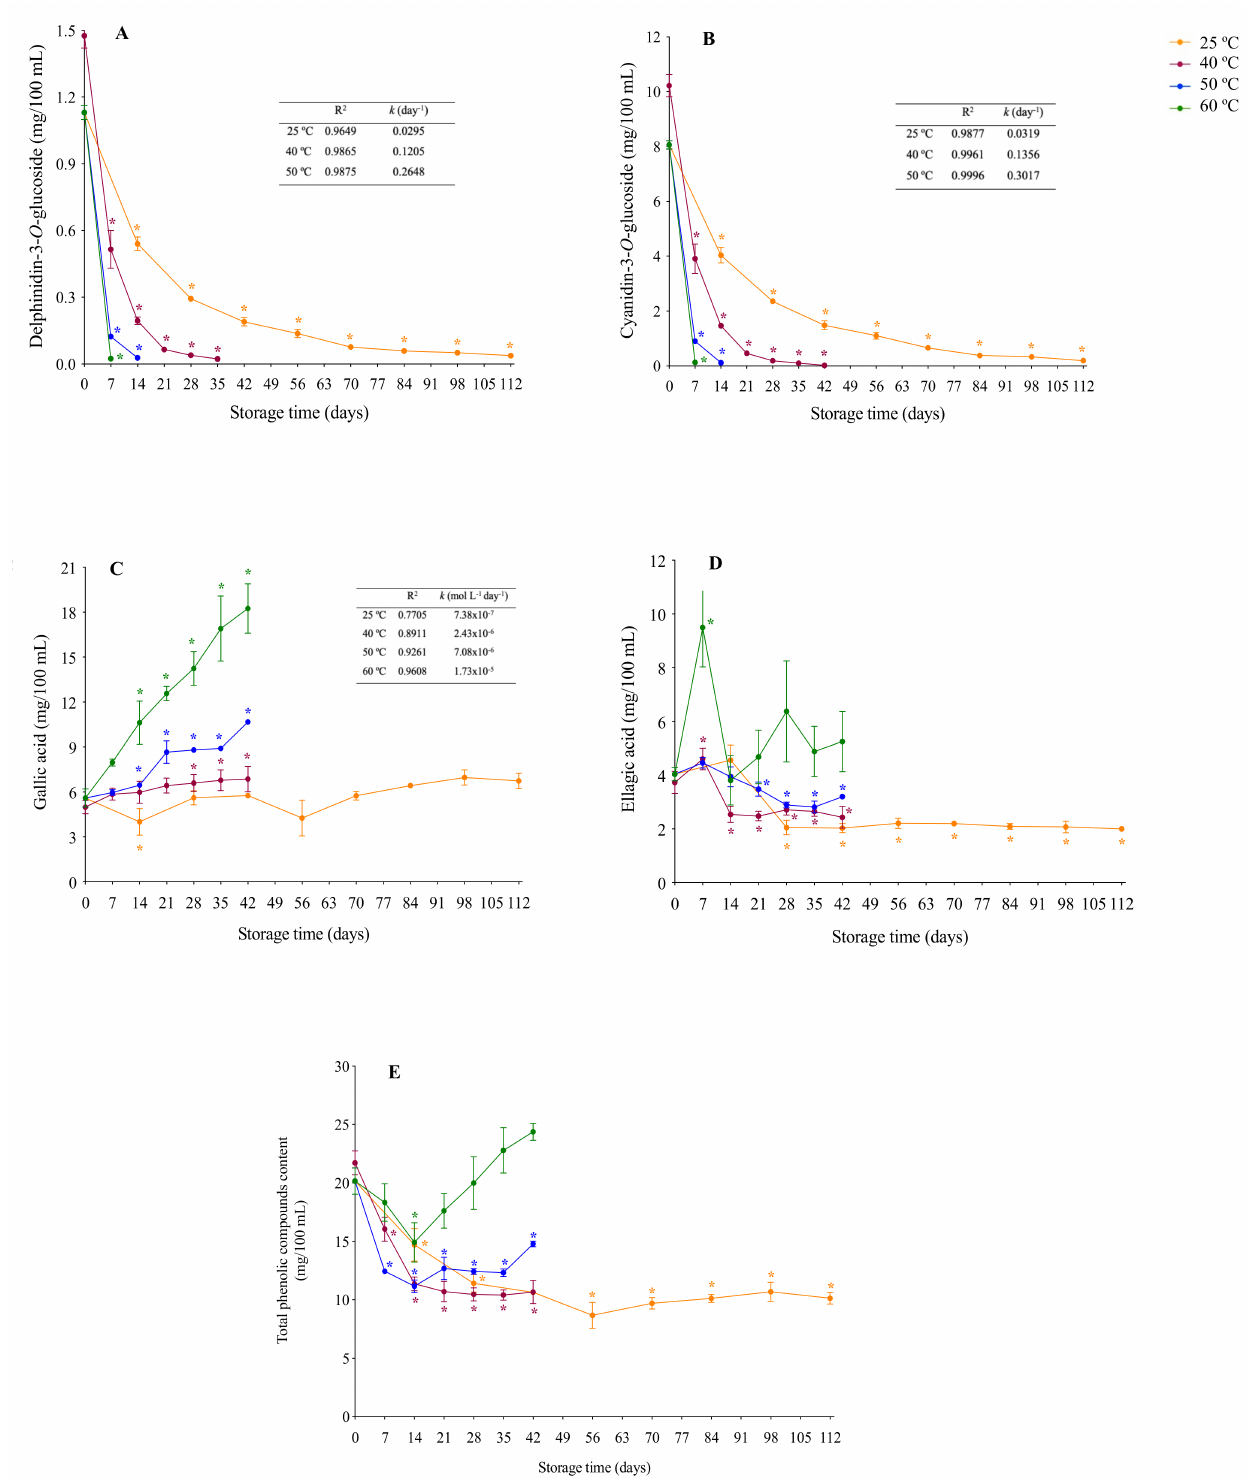
Figure 2. Contents of delphinidin-3- O -glucoside (D3G) ( A ), cyanidin-3- O -glucoside (C3G) ( B ), gallic acid ( C ), ellagic acid ( D ) and total phenolic compounds ( E ) of unsweetened jaboticaba juice during storage. First-order degradation kinetics parameters of D3G ( A ) and C3G ( B ) and zero-order formation kinetics parameters of gallic acid ( C ) are shown in the inserted tables. Asterisks indicate means significantly different from day zero for each temperature (One-way ANOVA followed by Dunnett’s post hoc test; p <